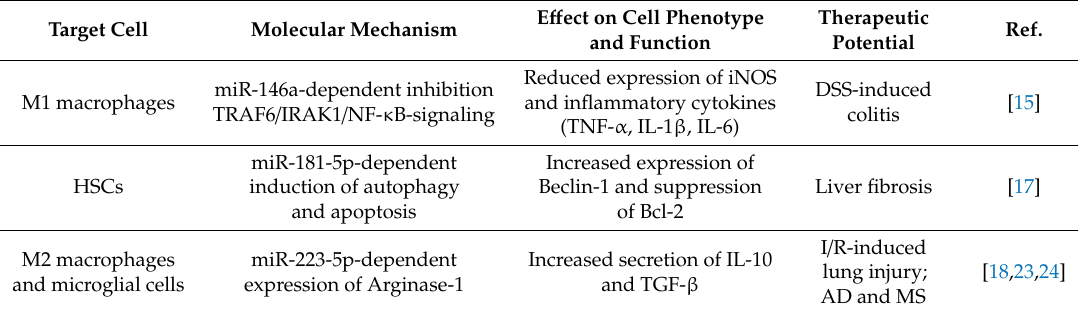
Table 1. E ff ects of MSC-Exos on immune